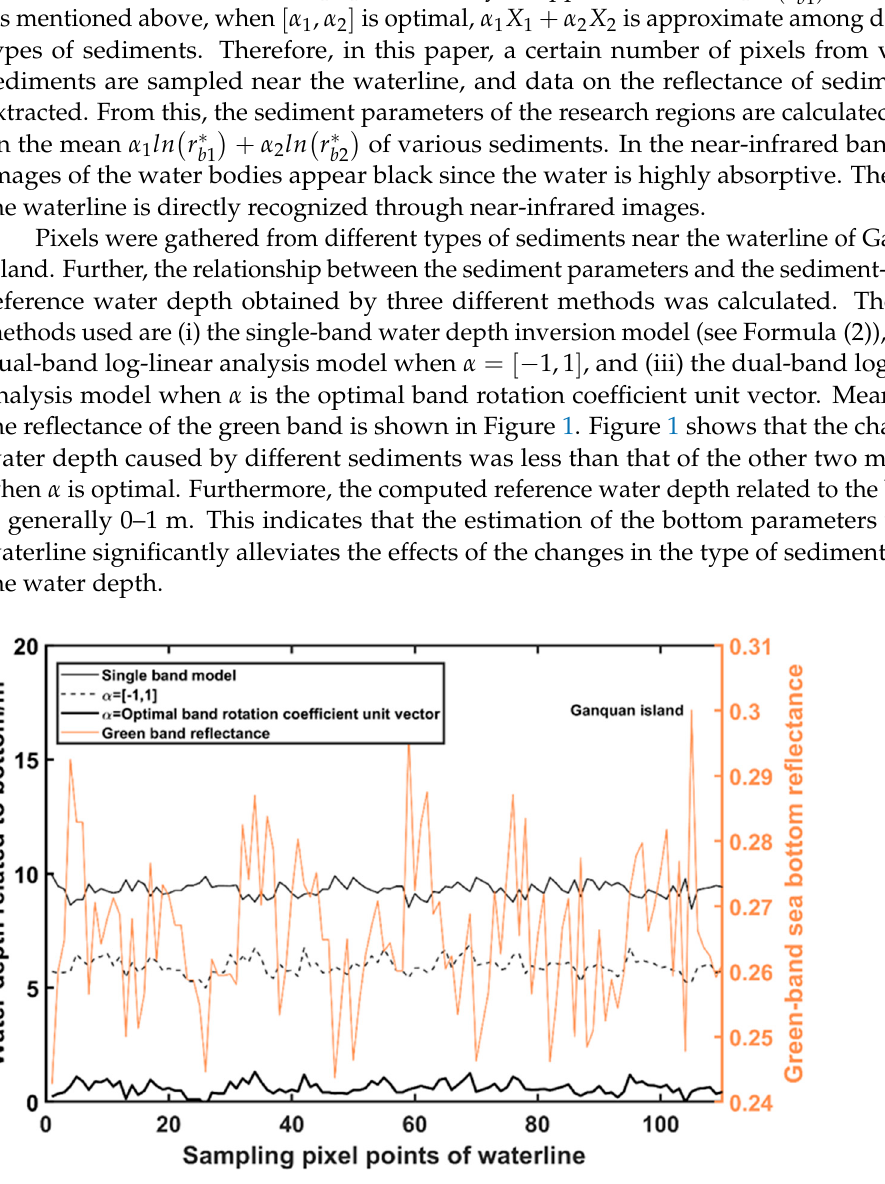
Figure 1. The reference water depth values along the waterline were obtained from three different bottom parameters and green band reflectance (Ganquan Island).